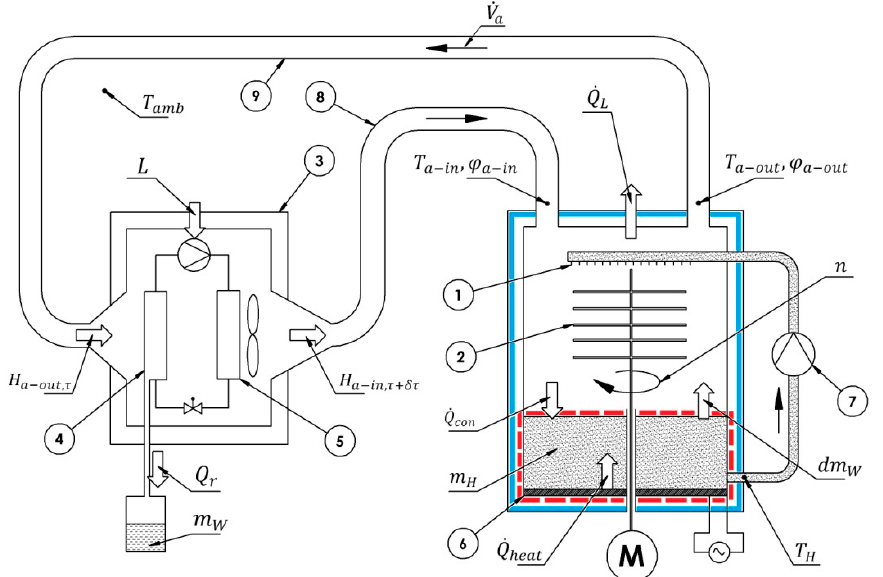
Figure 1. Schematic diagram of a closed-loop honey dehydrator: 1—honey sprayer; 2—mixer; 3—heat pump; 4—evaporator; 5—condenser; 6—electric heaters; 7—honey pump system; 8—air supply line; 9—air return line.